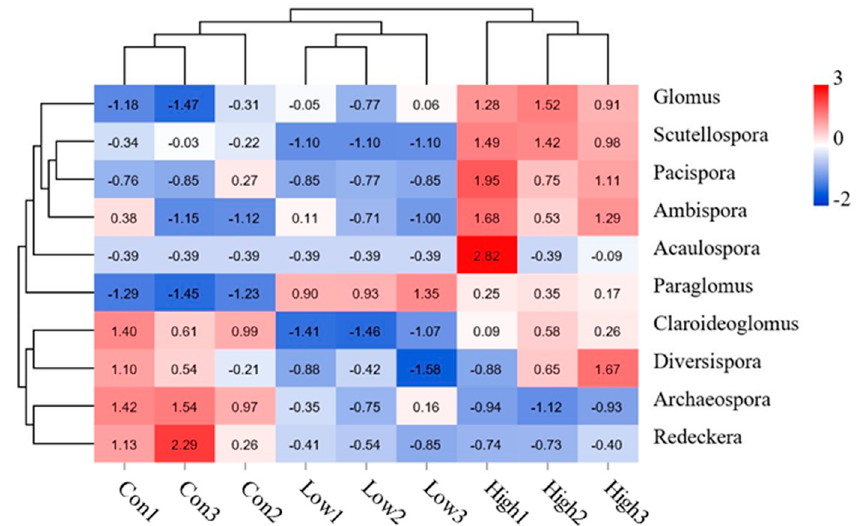
Figure 4. Heatmap analysis of the relative abundance of AMF genera in rhizospheric soil treated with different concentrations of biogas slurry.